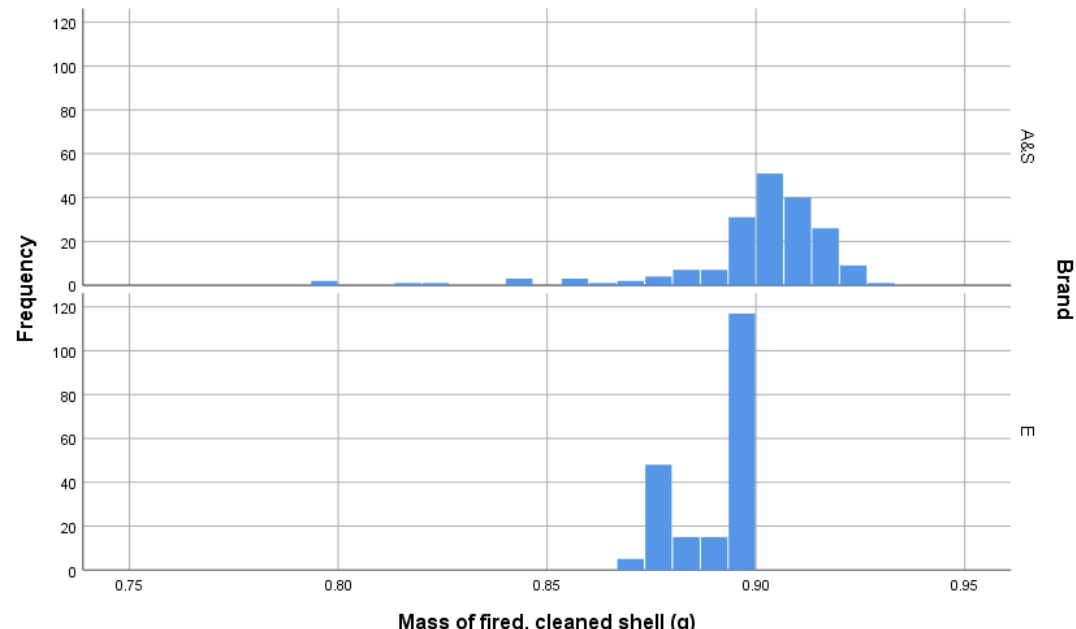
Figure 12. Plot of cartridge weights post firing after residue has been removed by cleaning.